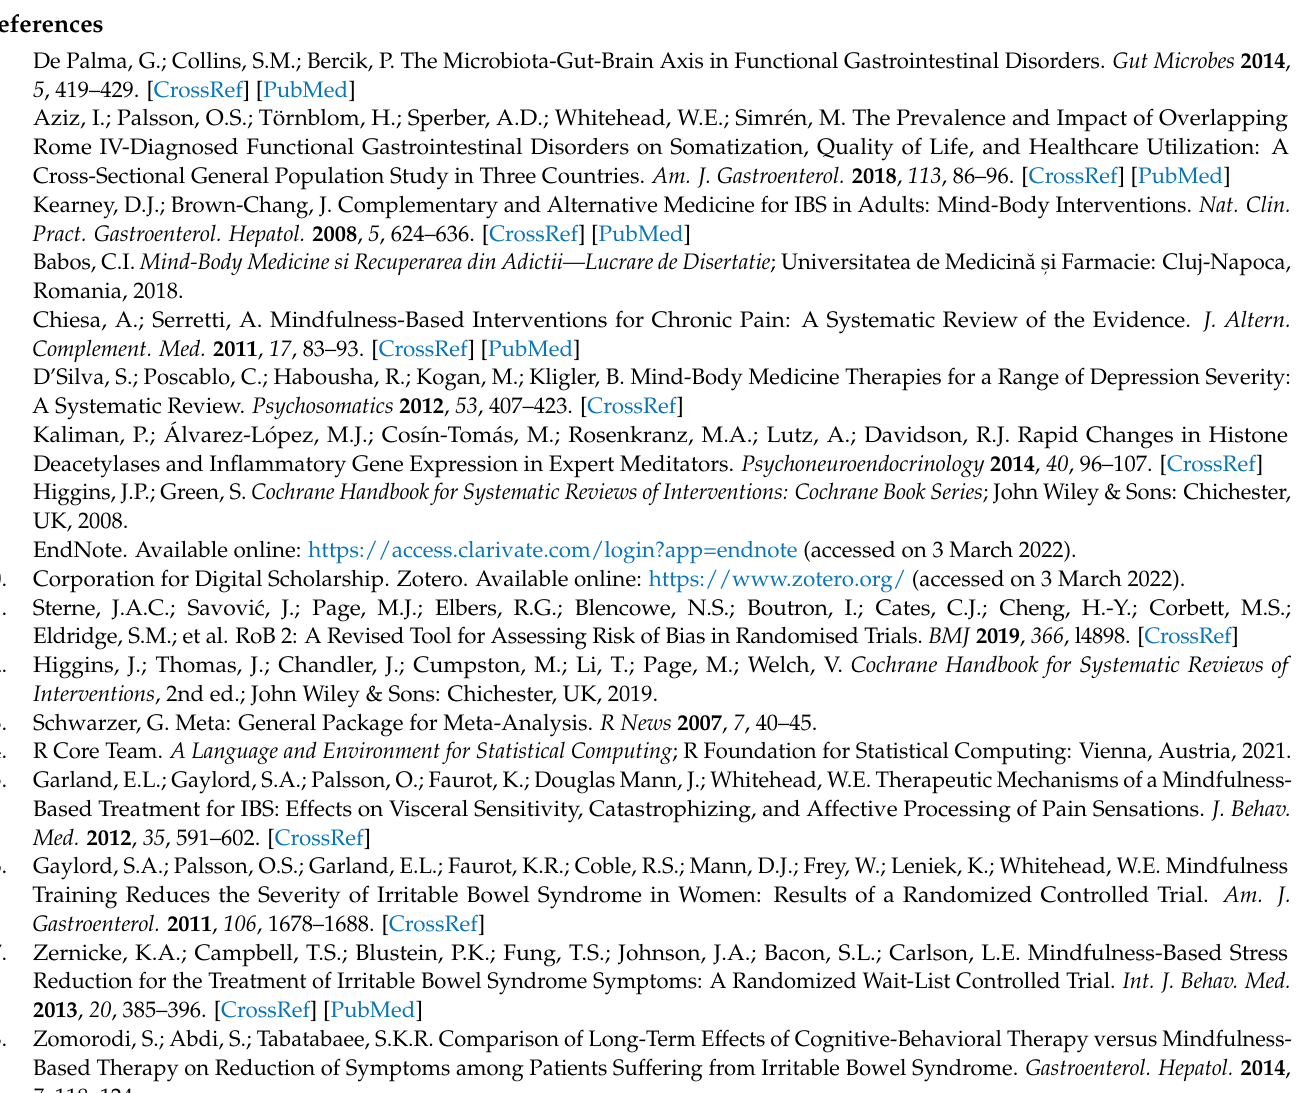
Table S3: Study inclusion and exclusion criteria; Figure S1: Quality assessment of the selected randomized controlled parallel trials using Risk of bias 2 tool from Cochrane Collaboration; Figure S2: Leave-one-out sensitivity analysis for irritable bowel syndrome quality of life standardized mean